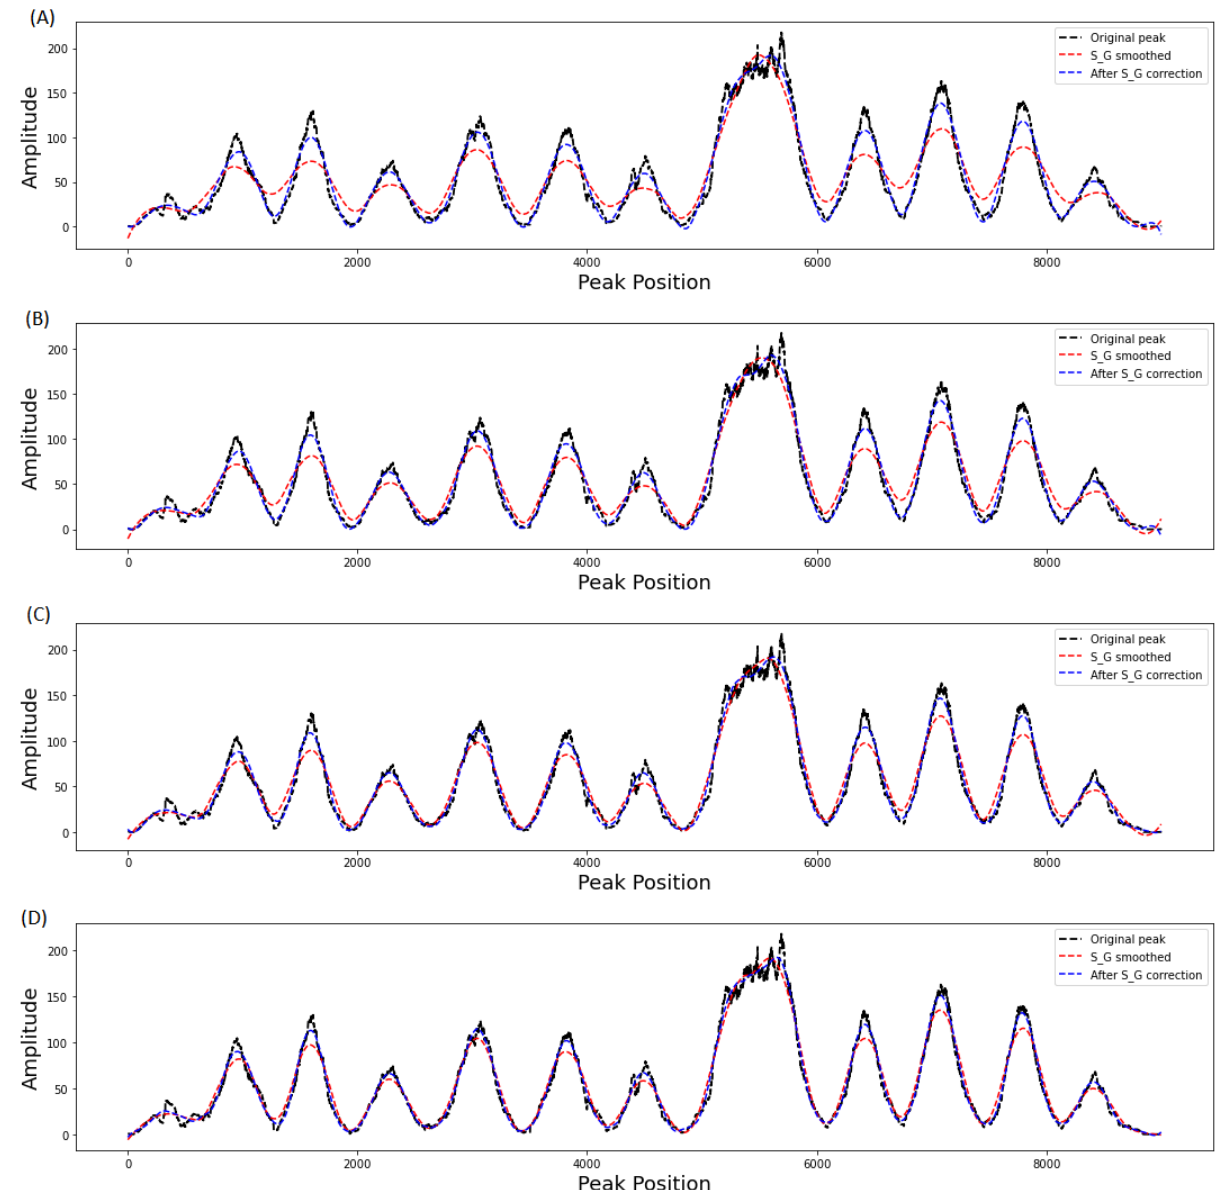
Figure 3. Smoothing performance of Adaptive Savitzky–Golay after correction. Adaptive SG filtering before correction; ( A ): SG filter k 1 = 2, m 1 = 253. ( B ): SG filter k 2 = 3, m 2 = 201; ( C ): SG filter k 3 = 4, m 3 = 153. ( D ): SG filter k 4 = 5, m 4 = 51. Adaptive SG filtering after correction: ( A ): SG filter ( B ): SG filter k 1 = 2, m 1 = 315. ( C ): SG filter k 2 = 3, m 2 = 281; ( C ): SG filter k 3 = 4, m 3 = 193. ( D ): SG filter k 4 = 5, m 4 = 81. The dotted black line is the original peak and the dotted red-and-blue line is the SG smoothed before and after correction,